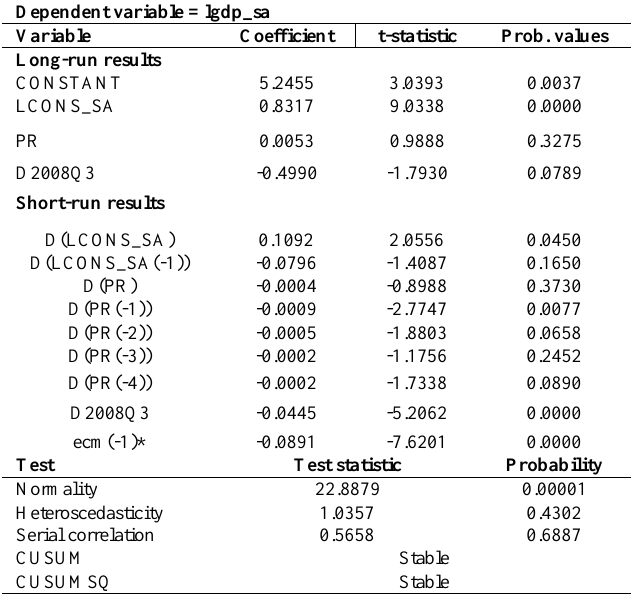
Table 3. Long-run and Short-run